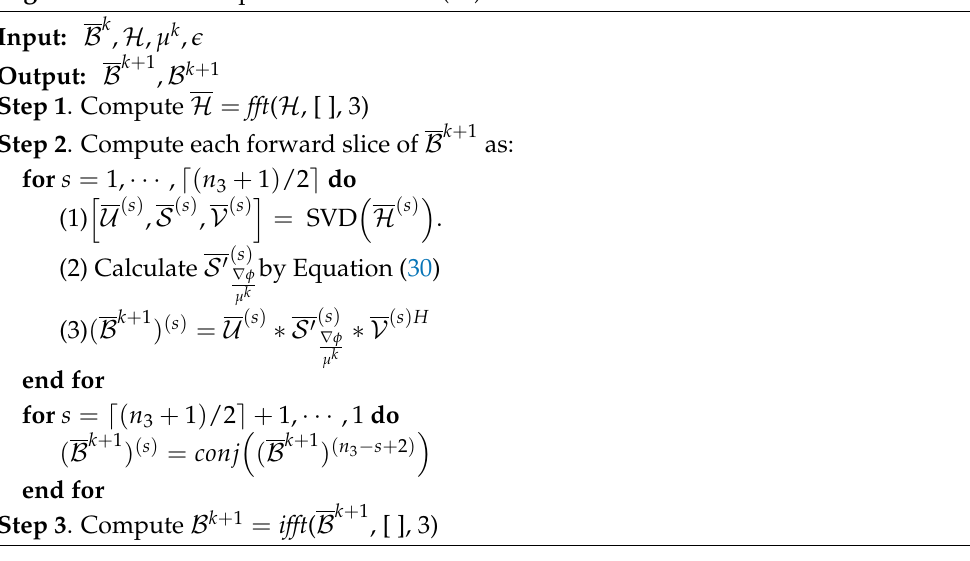
Algorithm 1 Solution process for model